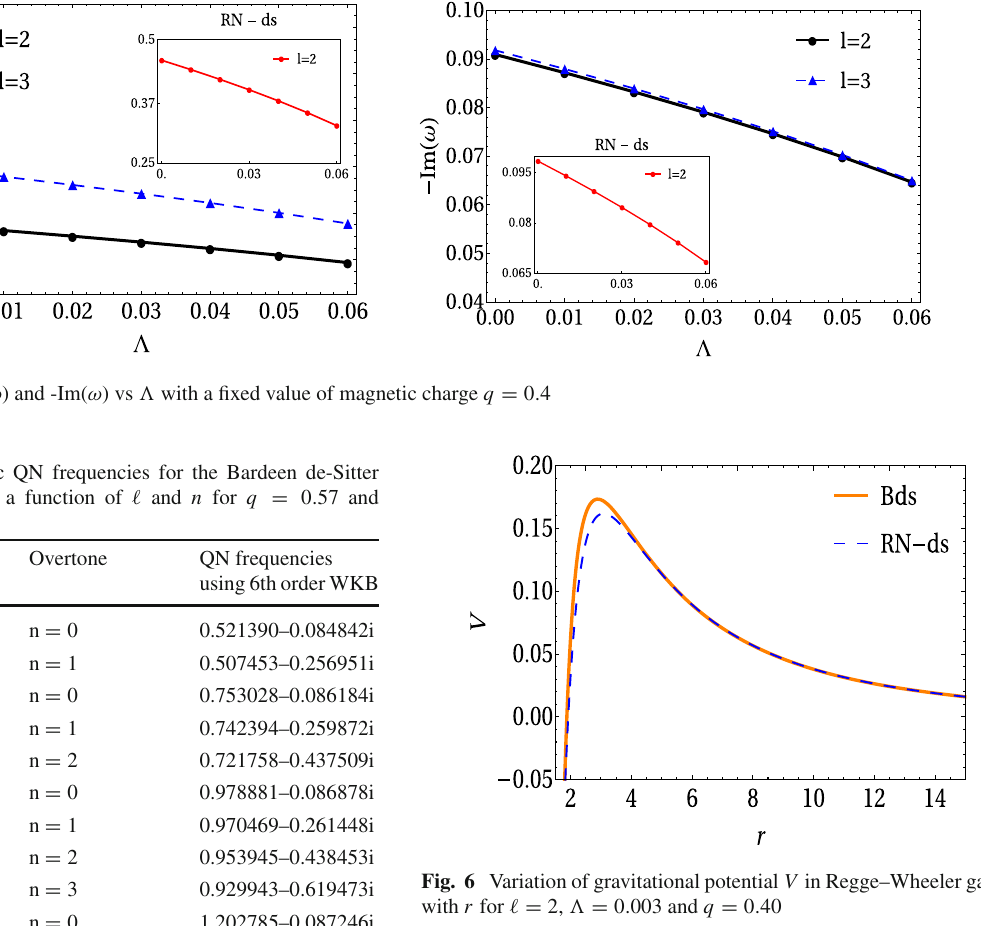
where L denoteslagrangianofthefieldand (cid:2) iscosmological